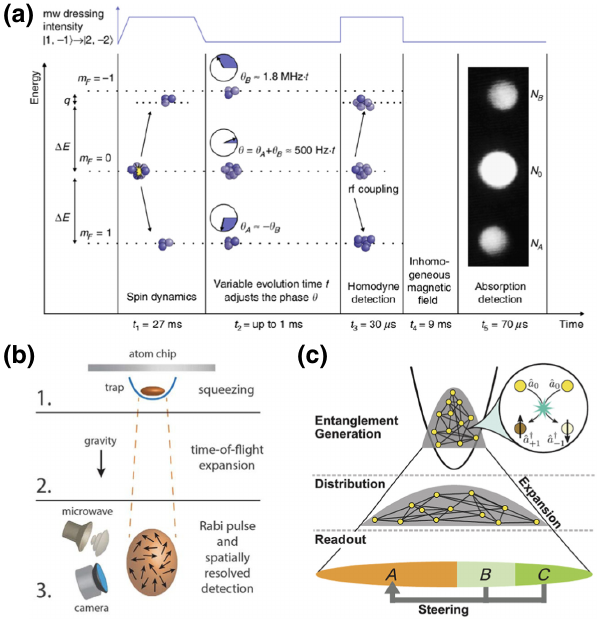
FIG. 4. (a) Schematic picture of the experimental sequence used by Peise et al. [71] to create entangled state of separated clouds of atoms distributed between the three Zeeman states m F = 0 and m F = ± 1; (b) Outline of the Fadel et al. [72] exper- iment to demonstrate entanglement and EPR steering between different parts of an expanded atomic cloud. (c) Experimental setup to detect spatially distributed entanglement in an expand- ing BEC and a multipartite steering between distinct parts of the expanded cloud. Reproduced from (a) Ref. [71], (b) Ref. [72], (c) Ref.